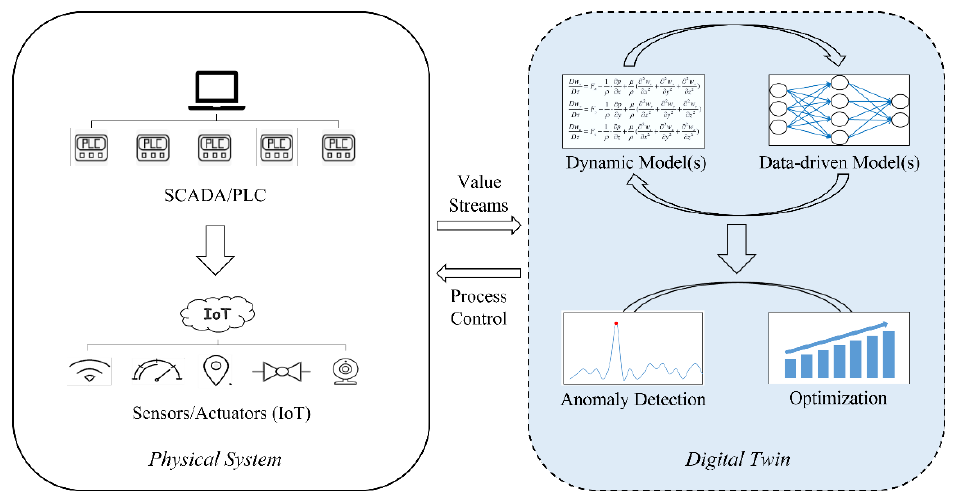
Figure 1. Schematic diagram of the digital twin concept (red point represents the detected anomaly).